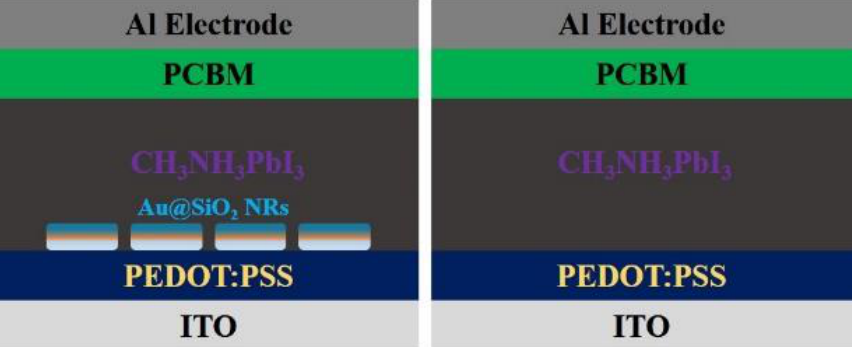
Figure 12. ( a ) Illustration of device structure with. ( b ) Typical TEM micrograph of Au@SiO 2 NPs. ( c ) J – V plots for Al 2 O 3 -only and Au@SiO 2 devices measured under STC. ( d ) Load dependence of Au@SiO 2 NPs on the device performance. Reproduced with permission from Ref. [119].